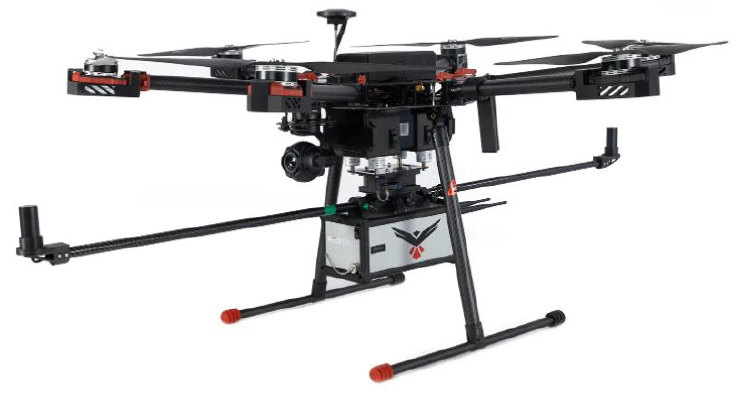
Figure 1. RedTail RTL-450 LiDAR on a Quadrotor UAV.